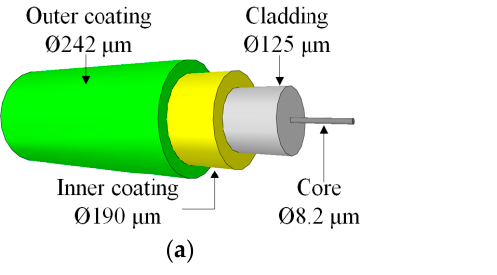
Figure 1. Optical fiber: ( a ) Typical cross section; ( b ) waveguide principle.